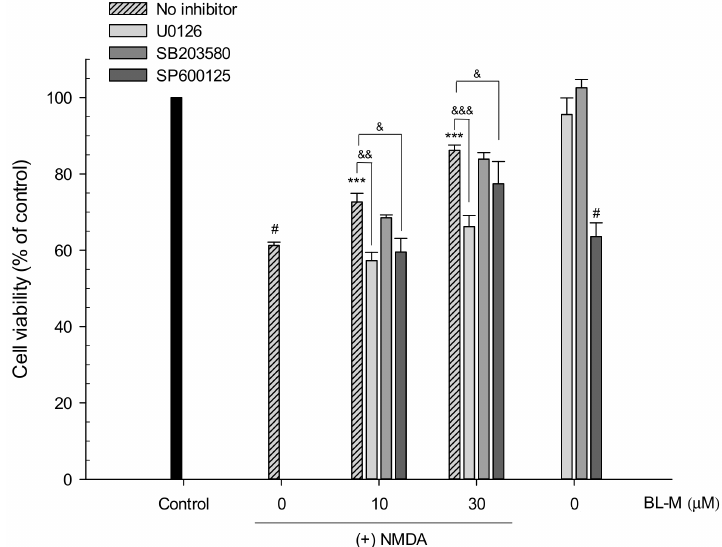
Figure 8. Reversal of the neuroprotective effect of BL-M by U0126 in primary cultured rat cortical cells. Cells (10–11 days in vitro) were pretreated with kinase inhibitors and exposed to 300 µ M NMDA for 15 min in the absence or presence of the indicated concentrations of BL-M. Cell viability was assessed by MTT reduction assays after 22–24 h of incubation at 37 ◦ C, as described in the Section 4. (# p < 0.001 vs. control; *** p < 0.001 vs. NMDA-treated cells; & p < 0.05, && p < 0.01, &&& p < 0.001 vs. NMDA + BL-M-treated cells). Each data represents the mean ± S.E.M. from at least three independent